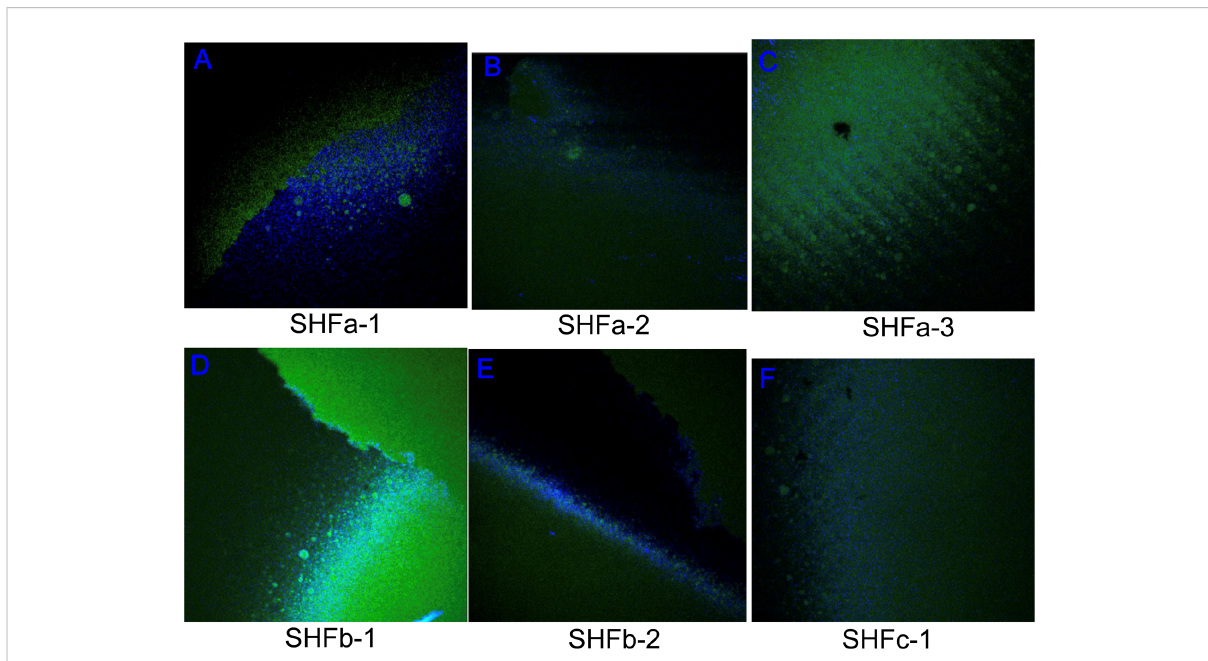
FIGURE 4 Representative confocal laser scanning microscopy images of extracellular polymeric substances comprising E faecium 1449 bio fi lm matrices